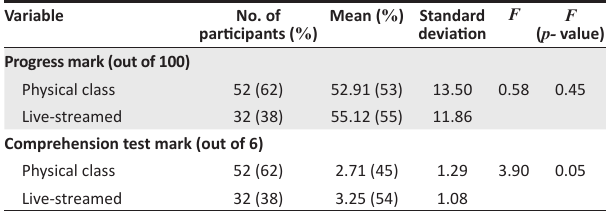
TABLE 2: Summary of results. Variable